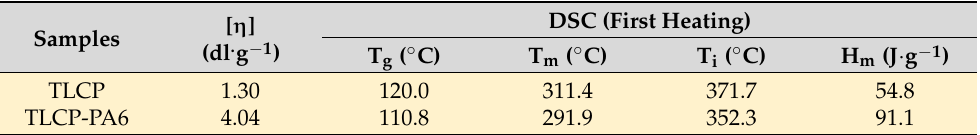
Figure 2. FTIR spectra of different samples, i.e., ( a ) pure MCPA6, ( b ) MCPA6/TLCP-PA6 blend (100 wt. %/15 wt. %) and ( c ) pure TLCP-PA6, respectively. Table 1. Intrinsic viscosities and thermal properties of TLCP and TLCP-PA6.